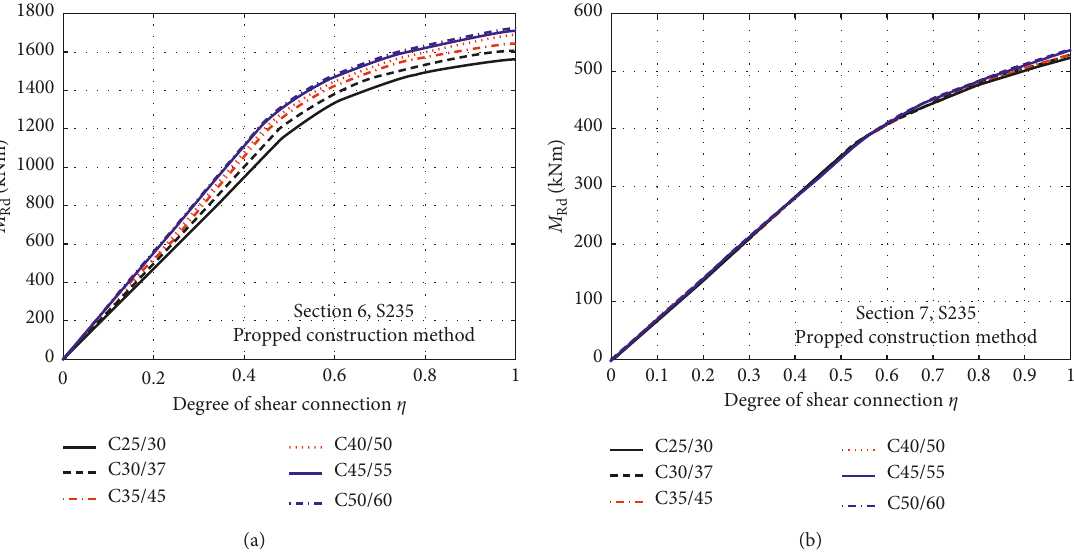
Figure 13: Effect of variation of class of concrete on resisting bending moment (degree of shear connection relation). Propped construction method. (a) Section 6 S235 and (b) Section 7 S450.